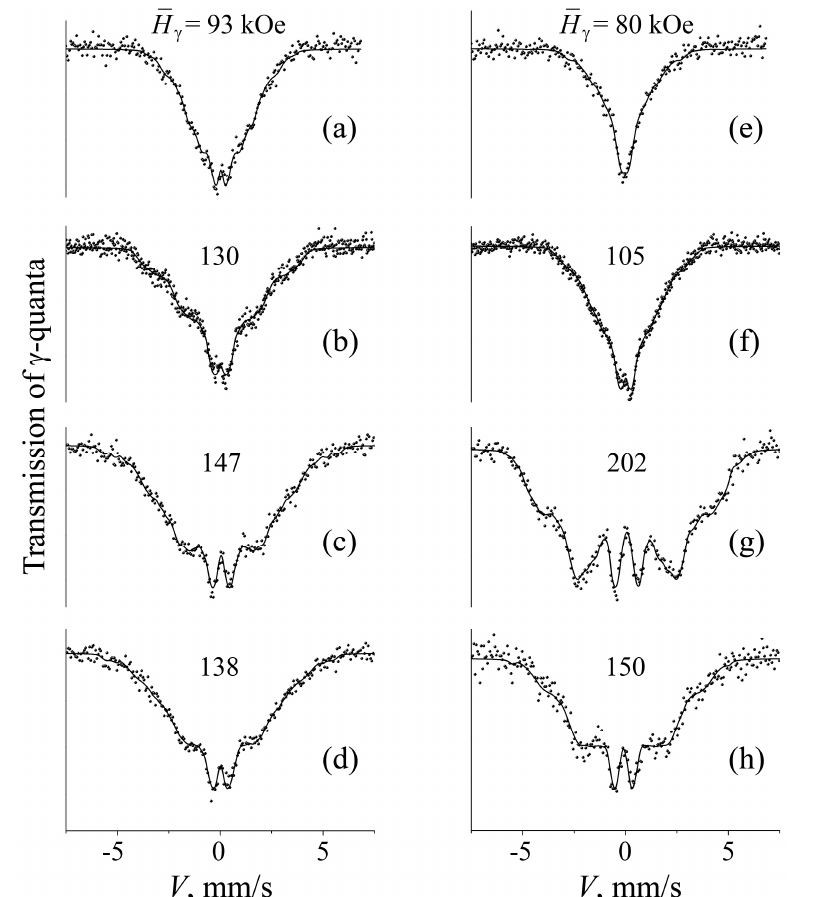
Figure 19. The spectra and magnitudes of H for the alloys ( a – d ) Fe 62.1 Ni 32.2 Si 5.7 and ( e – h ) Fe 63.5 Ni 33.4 Ti 3.1 . Treatment (state): ( a , e )–annealed at 923 K for 3 h (aged); ( b , f )–aged and irradiated by fast neutrons with the fluence F ~ 10 20 cm − 2 at 340 K; ( c , g )–aged and HPT treated with ε ~ 7.2 (5 revs) at 298 K; ( d , h )–aged, HPT treated, and irradiated by electrons with F ~10 19 cm − 2 at 430 K.